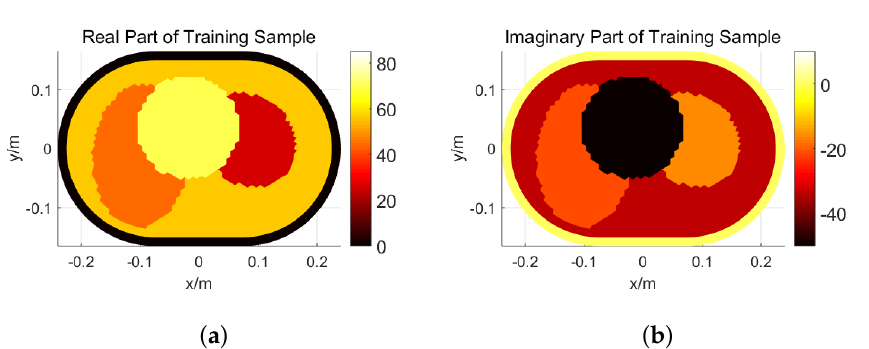
Figure 3. An example of training samples at 433 MHz: ( a ) Real Part; ( b ) Imaginary part.